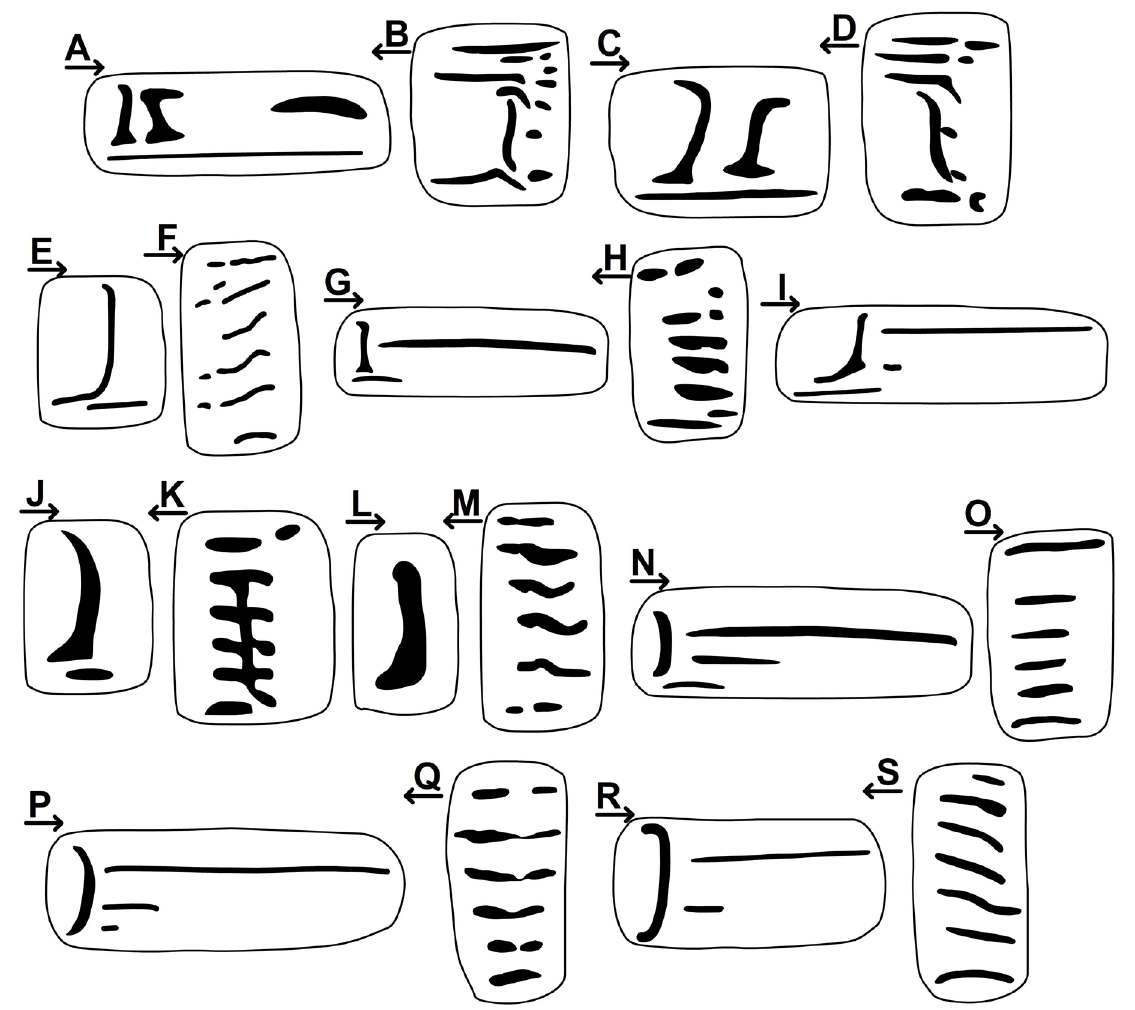
Fig. 21. Parietal (A, C, E, G, I, J, L, N, P, R) and palatal (B, D, F, H, K, M, O, Q, S) plication of species